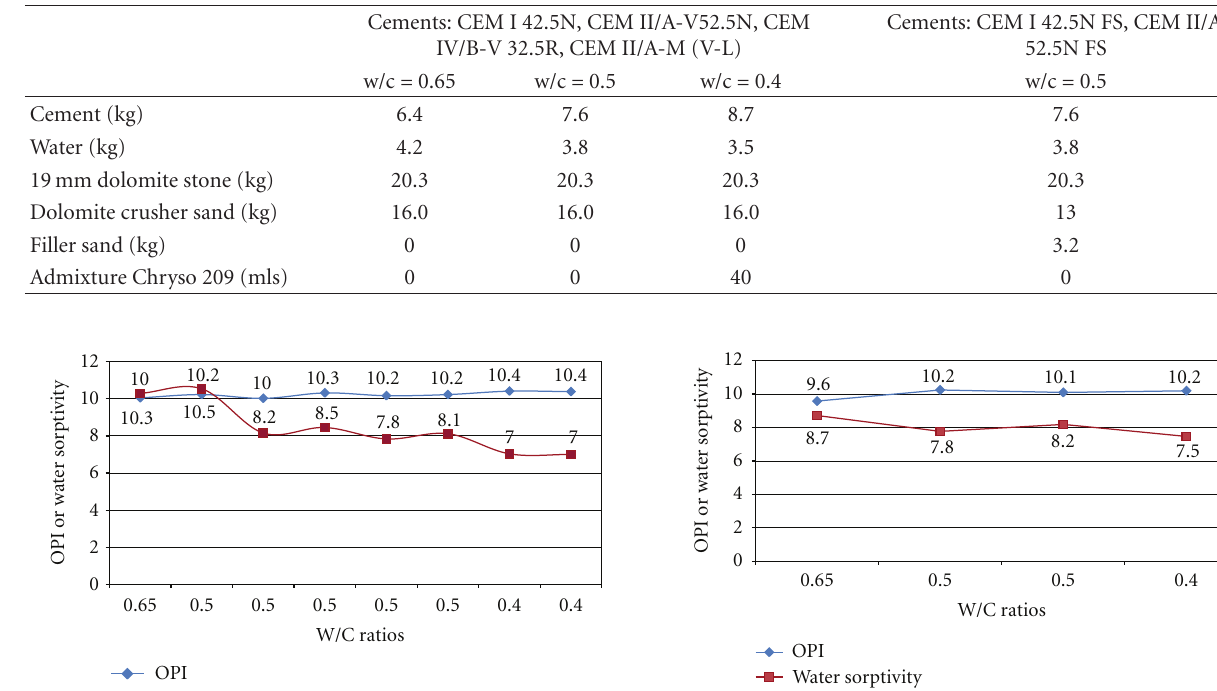
Table 1: Mixtures for the various concretes.